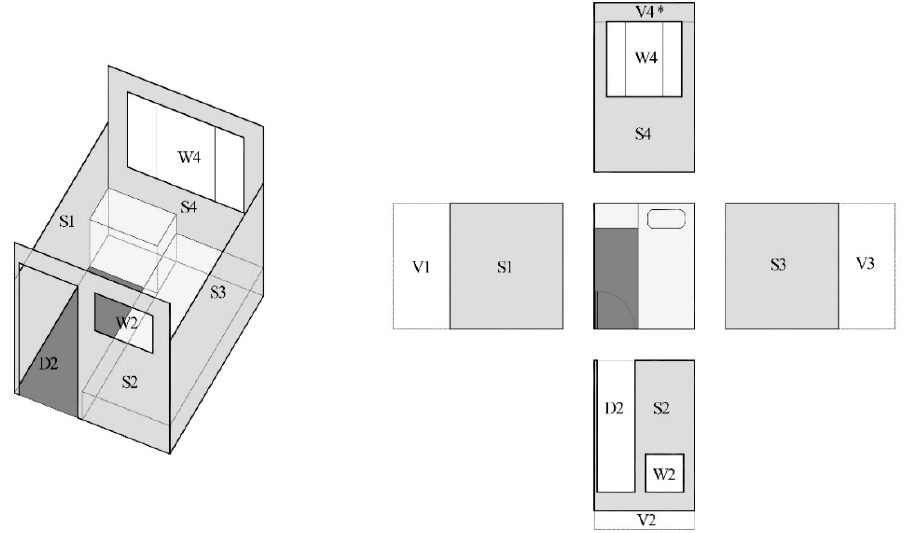
Figure 6. Typical bedroom unit for the calculation (drawn by the authors).